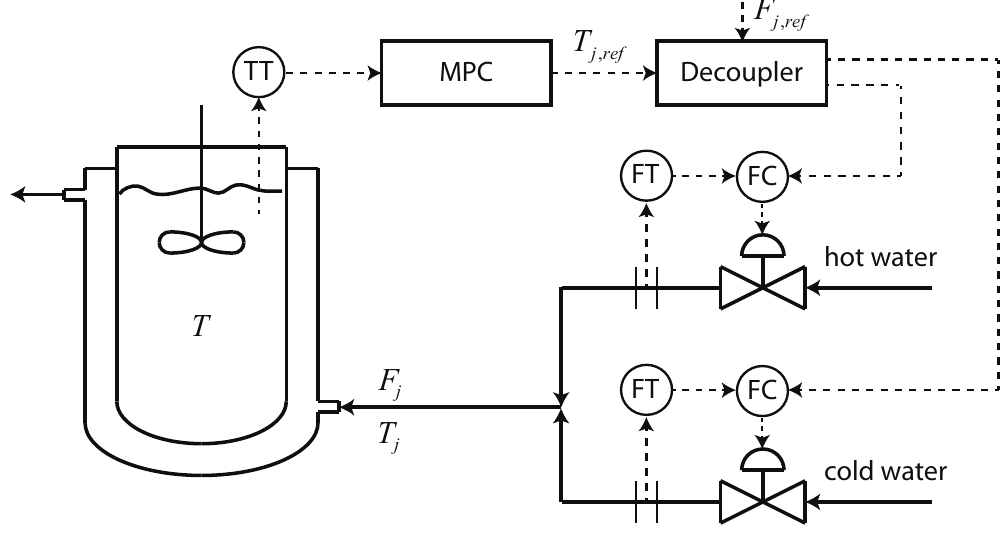
Figure 4. Schematic of the jacketed stirred tank and the cascade control system used to control the water temperature inside the tank. The reference ( F jacket ( F ) was fixed at 2 j